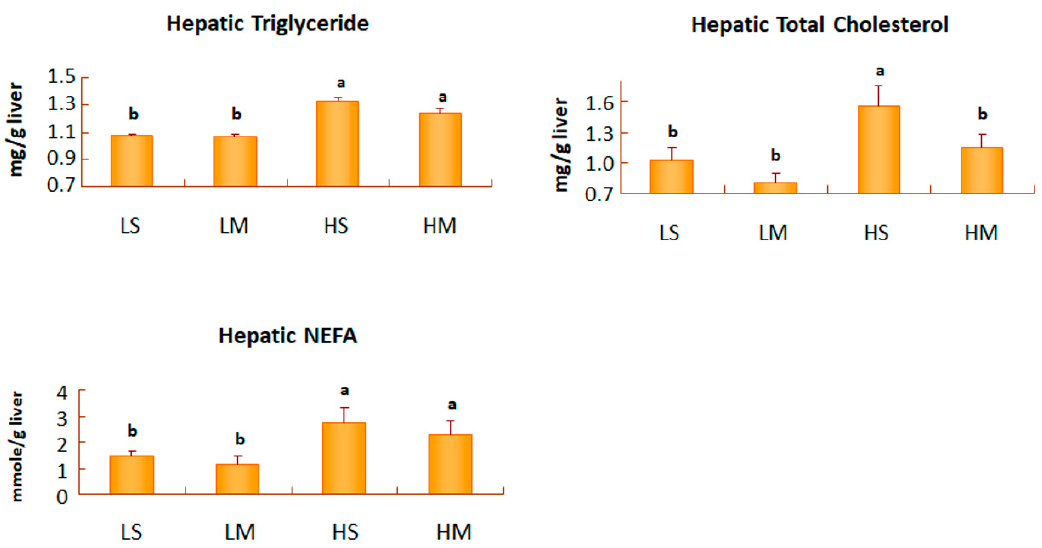
Figure 3. Hepatic triglyceride, total cholesterol, and non-esterified fatty acid concentrations of type 2 diabetes mellitus rats fed the different diets for 8 weeks. Data are expressed as the mean ± SEM ( n = 8 in each group). LS, diet contained 16% soybean oil; LM, diet contained 8% soybean oil and 8% medium-chain triglyceride oil; HS, diet contained 58% soybean oil; HM, diet contained 29% soybean oil and 29% medium-chain triglyceride oil. Values with different superscripts significantly differ at p < 0.05.